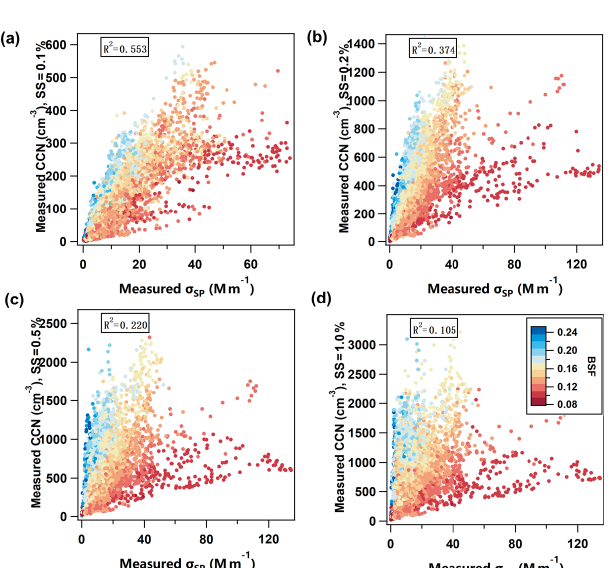
Figure 3. Relationship between R CCN /σ ( = N CCN (meas) /σ sp ) and BSF at SMEAR II at four supersaturations (SS): (a) 0.1%, (b) 0.2%, (c) 0.5%, and (d) 1.0%. Grey symbols: all data; red sym- bols: data at σ sp > 10Mm − 1 . Both σ sp and BSF were measured at λ =